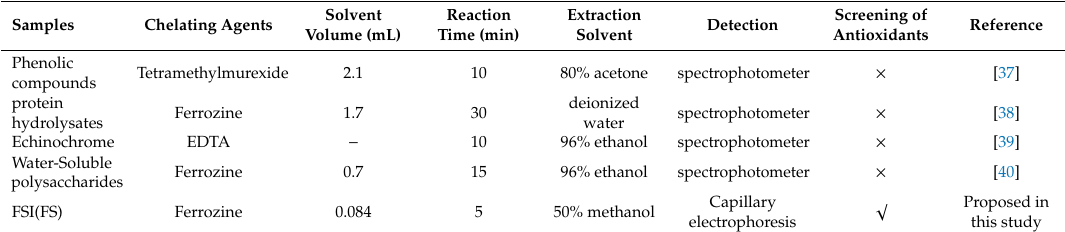
Table 8. The comparison of methods for determining the ability of chelating ferrous